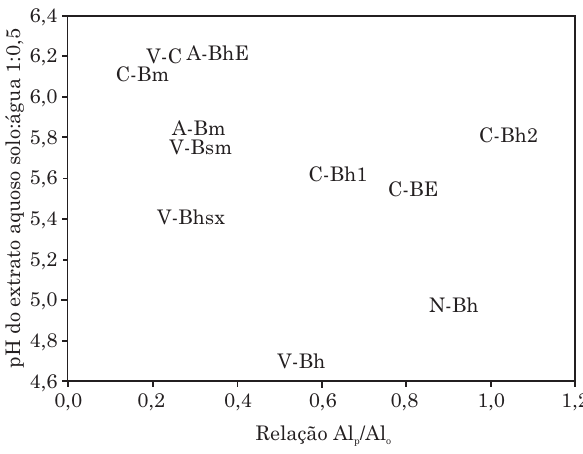
Figura 3. Dispersão de pontos entre a relação Al p /Al o e o pH da solução do solo de horizontes iluviais e C dos perfis estudados (r = -0,611, p<0,05). Primeira parte da legenda representa o perfil do solo – C: Coruripe floresta (EKo), N: Neópolis coco (EKg), A: Acajutiba eucalipto (RQo), V: Nova Viçosa eucalipto (ESKo). Segunda parte